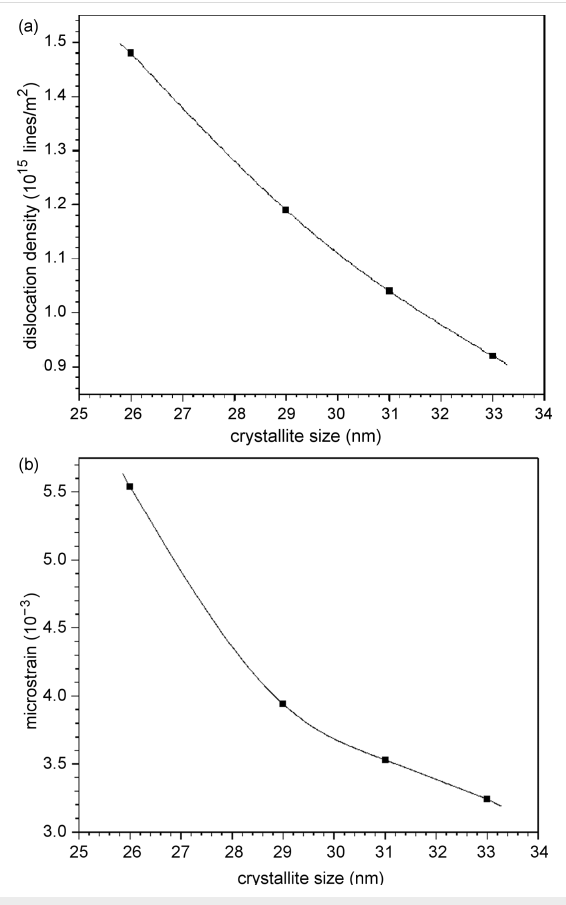
Figure 4: Variation of (a) dislocation density and (b) microstrain with crystallite size of the PbSe thin films.